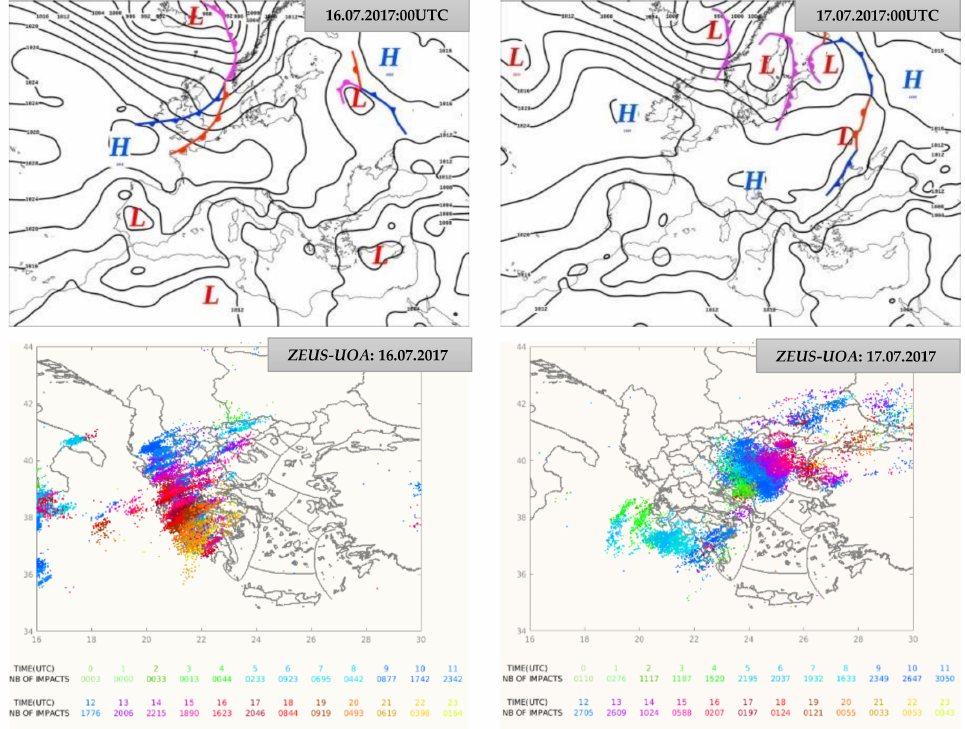
Figure 3. Surface map with frontal analysis (MetOffice) ( above ) and map of electrical discharges ( below ) from the ZEUS system (https://www.meteo.gr/talos (accessed on 10 May 2022) for 16 July 2017 00:00UTC ( left ) and 17 July 2017 00:00UTC ( right ) with the colors indicating the hour of the day with lightning